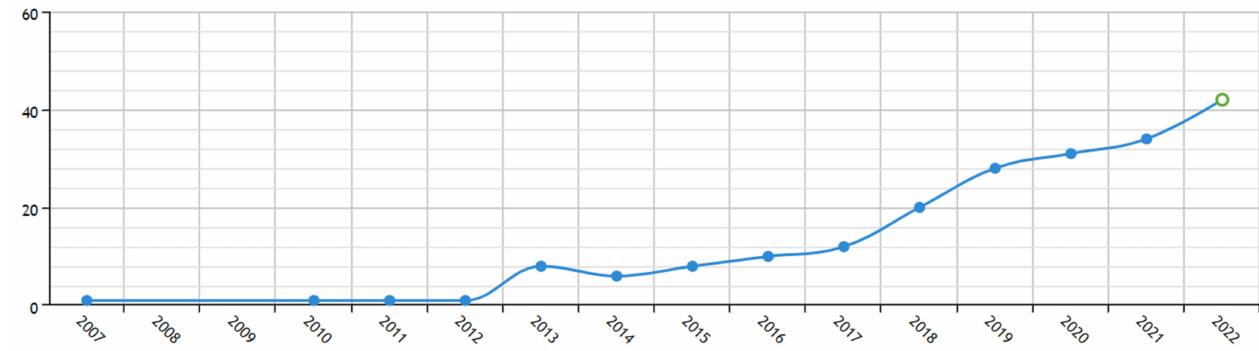
Figure 1. Number of publications (167 papers), October,